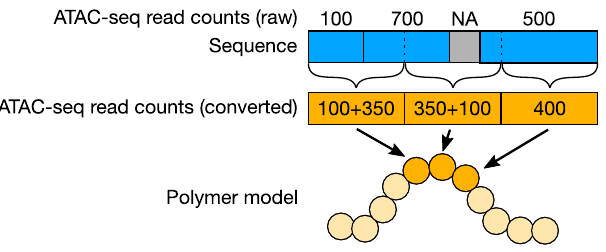
FIG. 12. The procedure for processing ATAC-seq peak data. The raw ATAC-seq read counts data are illustrated at the top track. Each chromatin segment has a read count value. The segments are not distributed uniformly, but have different lengths, and have missing parts. In our model, each locus has a fixed genomic length. Thus, to estimate the read counts associated with each locus, we calculate the contribution from the original ATAC- seq segments (blue track) to the segments represented by the locus (yellow track). NA indicates that the data is either not available or